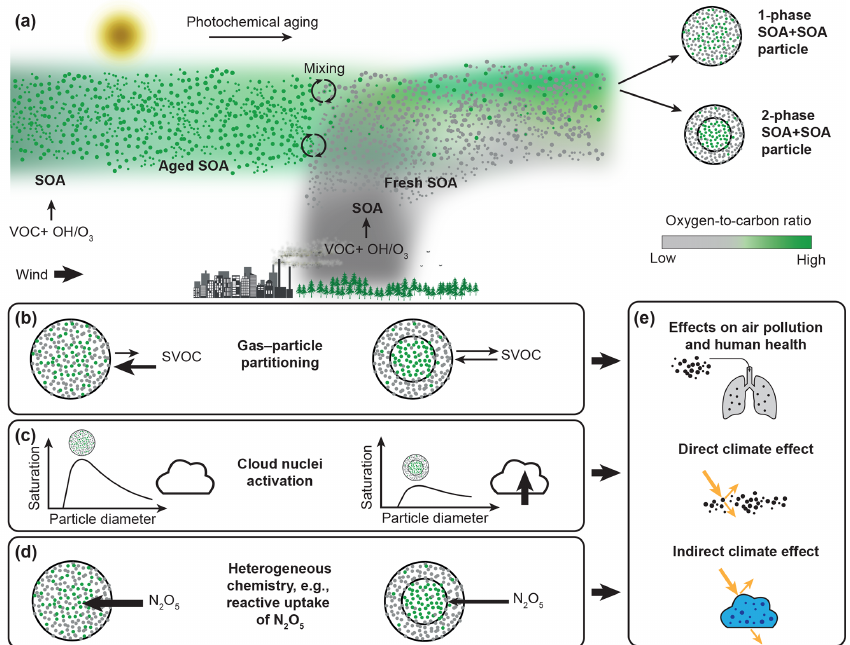
Figure 1. Formation of aerosol particles containing internal mixtures of different SOA types and impacts of the resulting number of con- densed phases on air quality, human health, and climate. (a) Mixing of air masses containing aged, highly oxidized background SOA material with air masses containing fresh, less oxidized SOA can result in SOA + SOA particles, with either one or two condensed phases, depending on the difference in the average O / C ratio of the aged and fresh SOA types that become internally mixed. (b) Organic molecules in single- phase SOA mixtures have reduced equilibrium partial pressures compared to when the two SOA types form distinct phases, allowing for an enhanced uptake of semi-volatile organic compounds (SVOCs). (c) The presence of a less oxidized organic phase making up the shell of a phase-separated SOA particle can lower the surface tension and thus allow the phase-separated particles to activate into liquid cloud droplets at lower supersaturations compared to SOA particles with a single, homogeneous organic phase. (d) The presence of a less oxidized organic phase of low water content can act as a diffusive barrier for mass transfer and affect heterogeneous chemistry, e.g., by limiting the reactive uptake of N 2 O 5 . (e) Altogether, the presence of multiple phases in SOA particles can have important implications for the impact of SOA on air pollution, human health, and climate. Figure based on Reid et al.